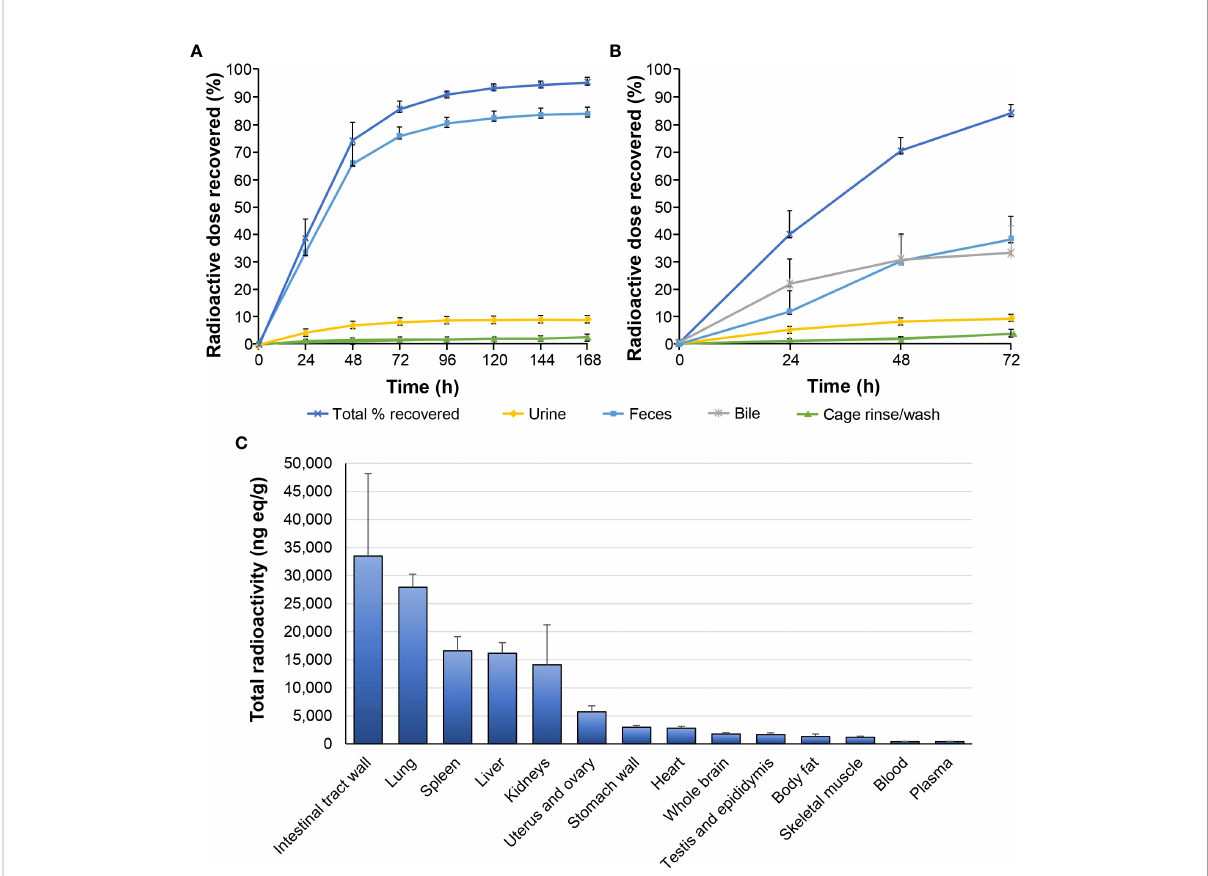
FIGURE 2 Tissue distribution and excretion of GLR2007 in Sprague Dawley rats. Intact and bile duct cannulated Sprague Dawley rats were administered with a single oral dose of [ 14 C]GLR2007 at 6 mg/100 m Ci/kg. (A) Cumulative excretion of radioactivity in intact rats over 168 hours following [ 14 C]GLR2007 dosing. (B) Cumulative excretion of radioactivity in bile duct cannulated rats over 72 hours following [ 14 C]GLR2007 dosing. (C) Total radioactivity (ng eq/g, mean ± standard deviation) detected in blood, plasma, and tissue of intact rats at 6 hours following [ 14 C] GLR2007